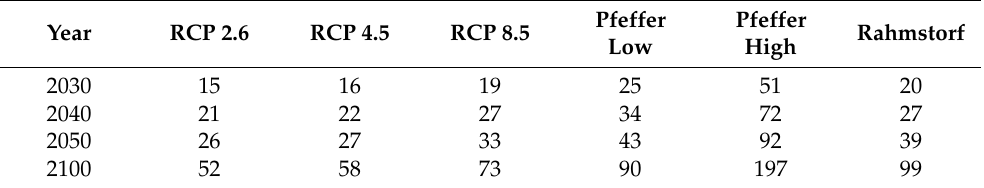
Table 5. Shoreline retreat (m) projected for the years 2030, 2040, 2050, and 2100, according to the different models and